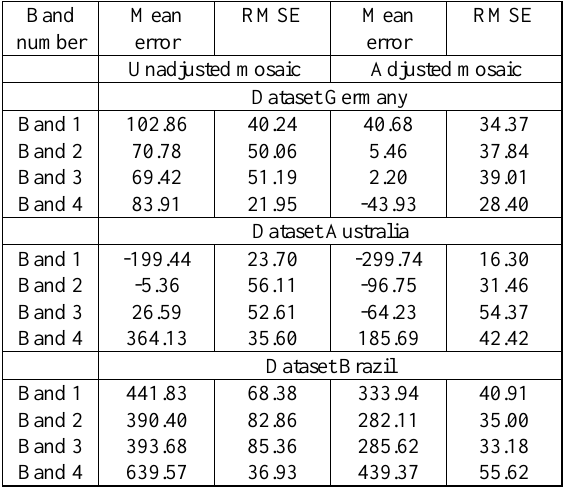
Table 3. Quality values for all processed scenes expressed in units of DN pixel differences (quantization: